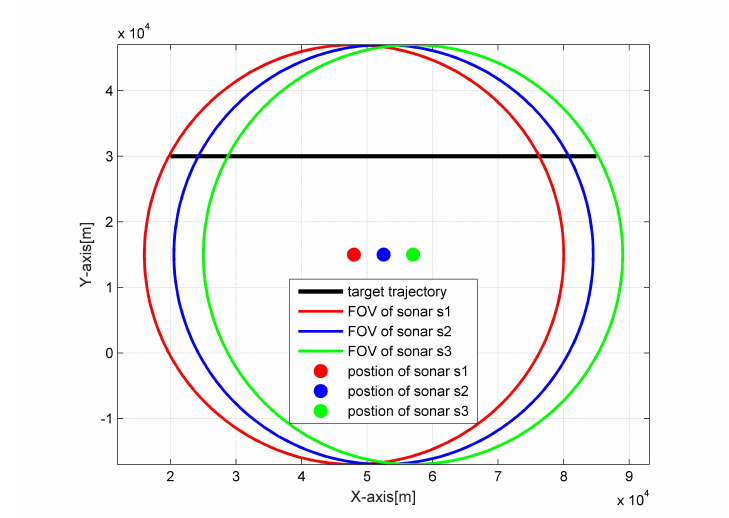
Figure 3. The target trajectory and surveillance areas of BO sonars.